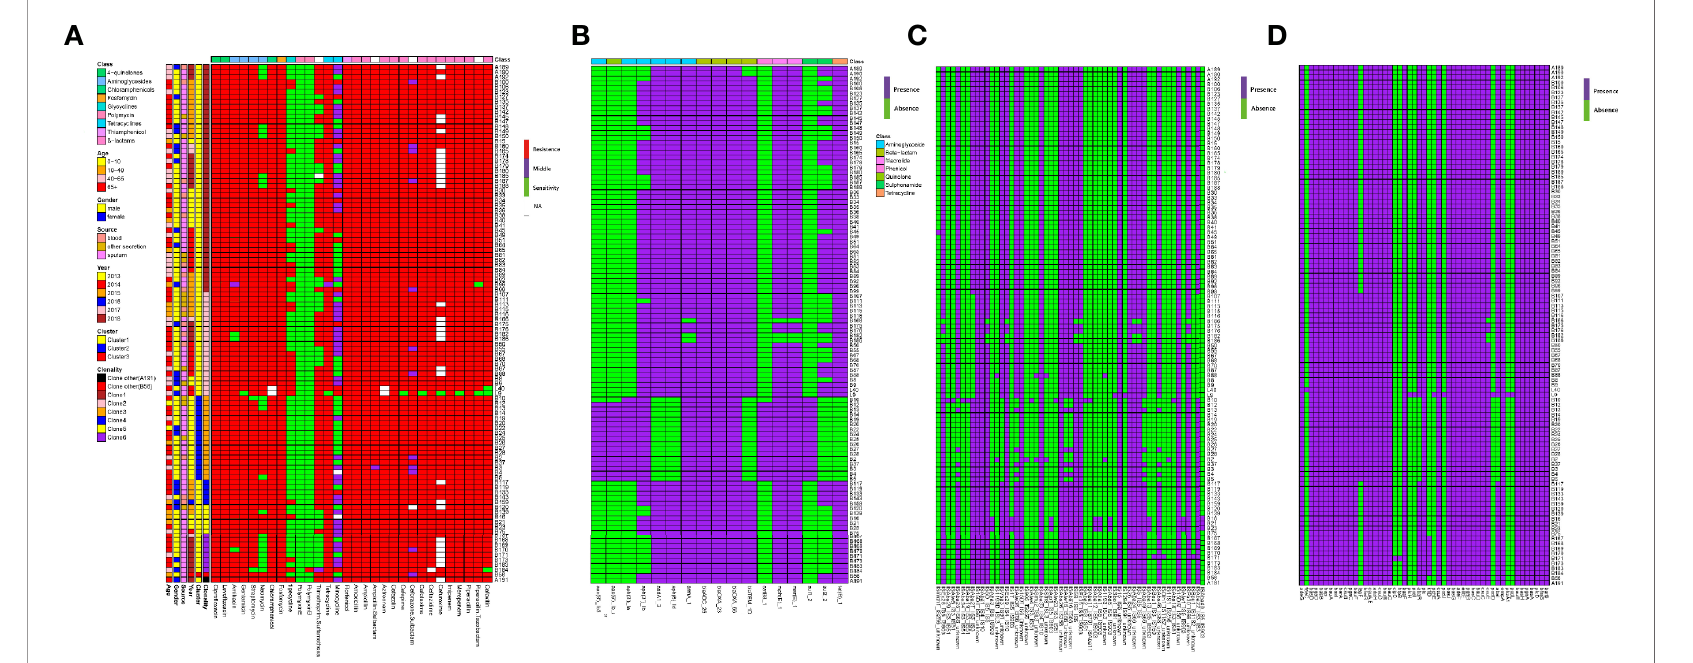
FIGURE 8 | MIC test and ARGs, virulence genes (VGs), insertion sequence (IS) identi fi cation of 105 samples from ICU rooms. (A) Results of MIC test; class of antibiotics and resistance strength are annotated as colored bars next to the main heatmap. (B) Results of ARG identi fi cation based on Res fi nder; (C) Results of IS based on IS fi nder; (D) Results of VG identi fi cation based on